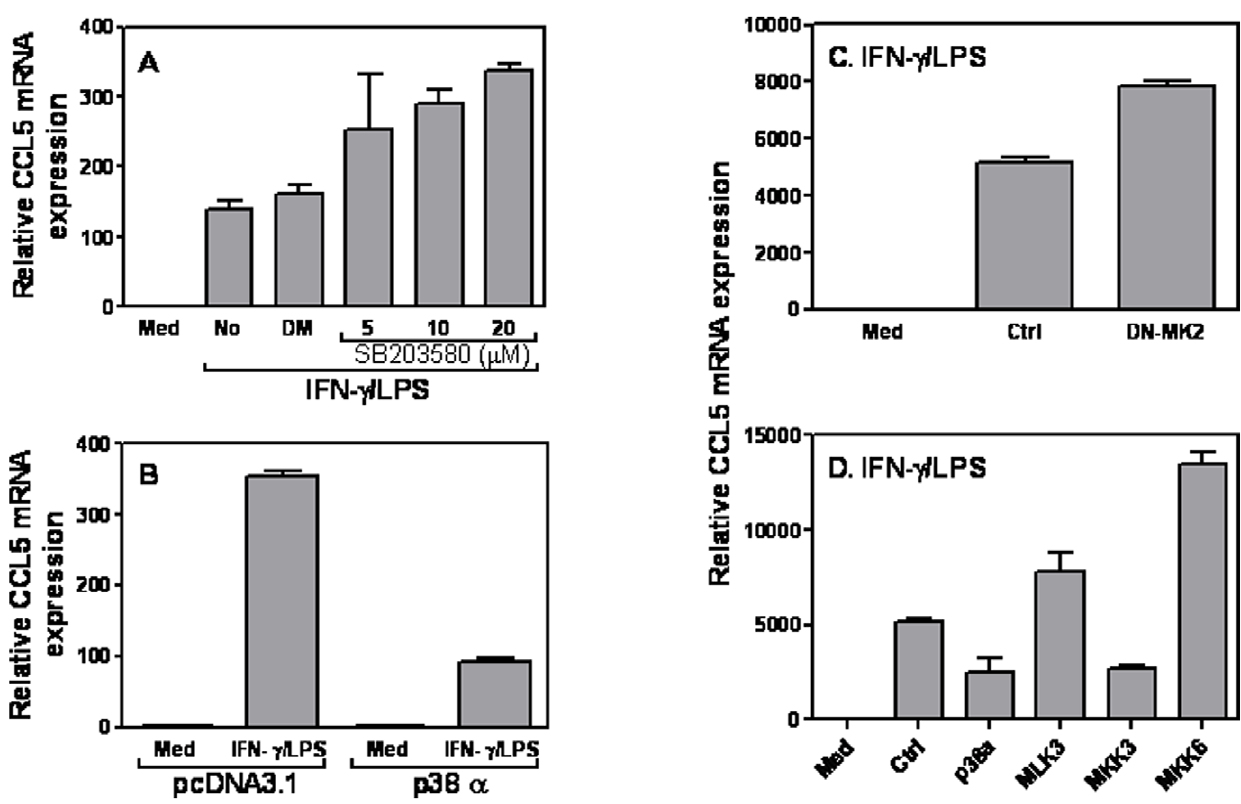
Figure 5. The role of p38 MAPK in CCL5 expression. (A) 1 6 10 6 A7r5 cells were treated with different amounts of a p38 MAPK antagonist SB203580 for 1 h prior to addition of various stimuli as indicated. An identical amount of dissolvent DMSO was used for negative controls. 6 hrs later, total RNA was extracted for measurement of CCL5 mRNA expression by qRT-PCR. 5 m g of different expression plasmids encoding different molecules involved in the p38 MAPK signaling pathway including p38 a (B), and DN-MK2 (C), as well as MLK3, MKK3, and MKK6 (D) or empty vector were transiently transfected with Lipofectamine2000. 48 h after transfection, the cells were treated with LPS (1 m g/ml) plus IFN- c (10 ng/ml) for 6 h, followed by measurement of CCL5 mRNA expression by qRT-PCR. qRT-PCR data were normalized relative to GAPDH mRNA expression levels in each respective sample and further normalized to the results from the un-treated group, which was set as 1. Results shown are mean plus SD of three independent experiments.